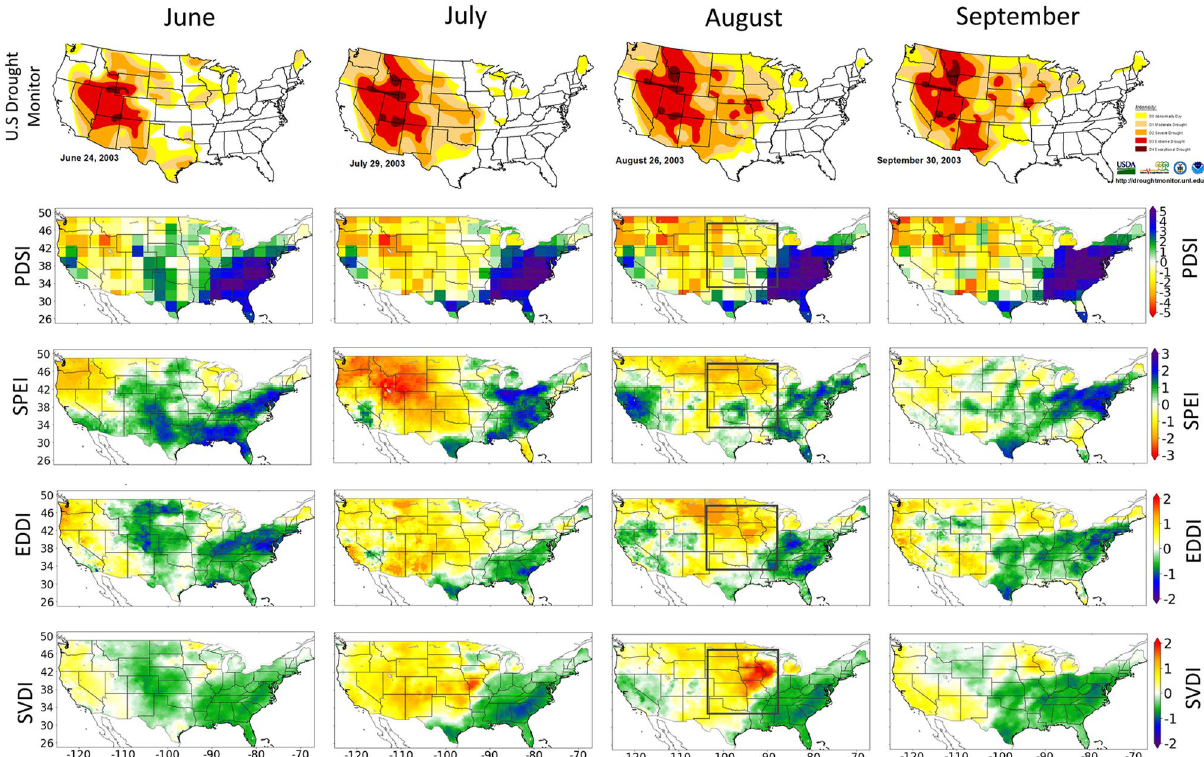
Figure 1. June, July, August, and September 2003 PDSI, SPEI (1-month), EDDI, and SDVI_NLDAS (SVDI). The black box represents a Flash Drought area from July 1–September 2, 2003. The USDM index is a weekly index, and dates represent the week ending that date. The SVDI index is a daily index, and the monthly value is averaged for each month. The EDDI index is averaged on the last day of each month for the previous 30 days. The SVDI, PDSI, SPEI, and EDDI plots were generated using the Matplotlib 41 library for the Python programming language (https:// matpl otlib. org/). The USDM maps are courtesy of NDMC-UNL and were accessed from https:// droug htmon itor. unl. edu/ NADM/ Maps. aspx. The USDM is jointly produced by the National Drought Mitigation Center (NDMC) at the University of Nebraska-Lincoln(UNL), the United States Department of Agriculture, and the National Oceanic and Atmospheric